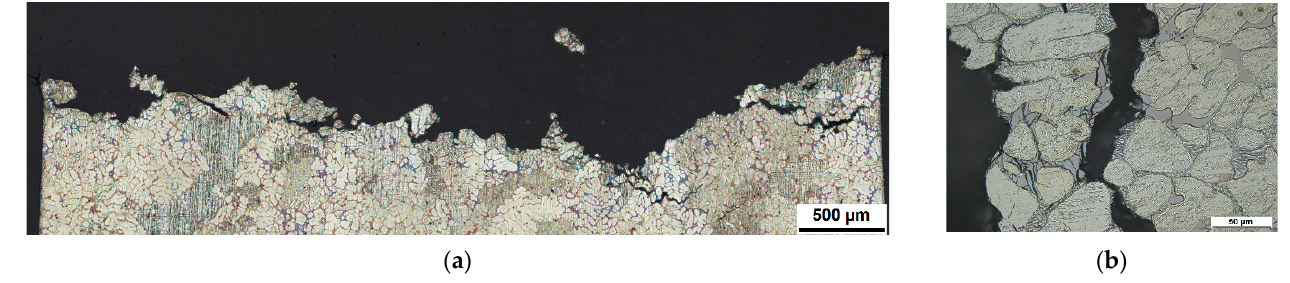
Figure 14. Cross-sectional micrographs of fracture surface after tensile load showing many sub-cracks branching off the main crack ( a ) and magnified area showing highly twinned microstructure ( b ).